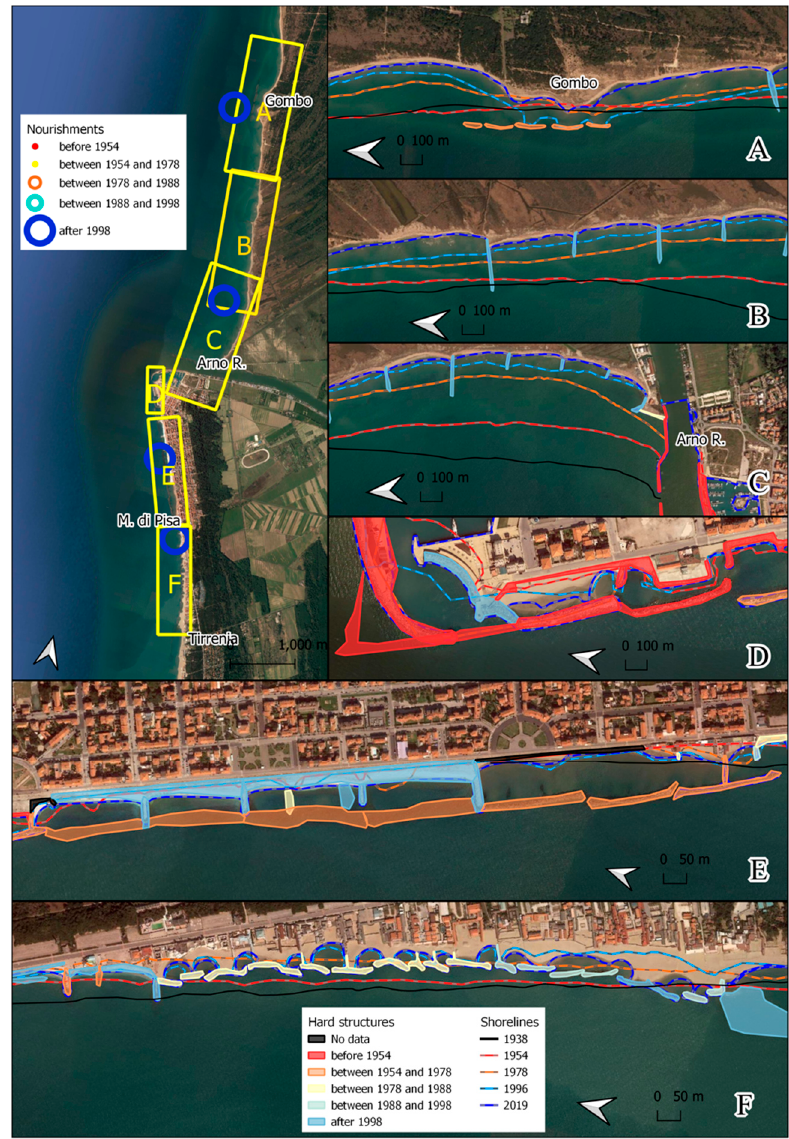
Figure 8. Identification of hard and soft operations along the sector comprised between Gombo and Tirrenia. Polygons represent the hard structures; dots represent the nourishments. The yellow frames in the top left panel correspond to the zoom in panels to the right and at the bottom. The background image has been retrieved from the Google Earth database.